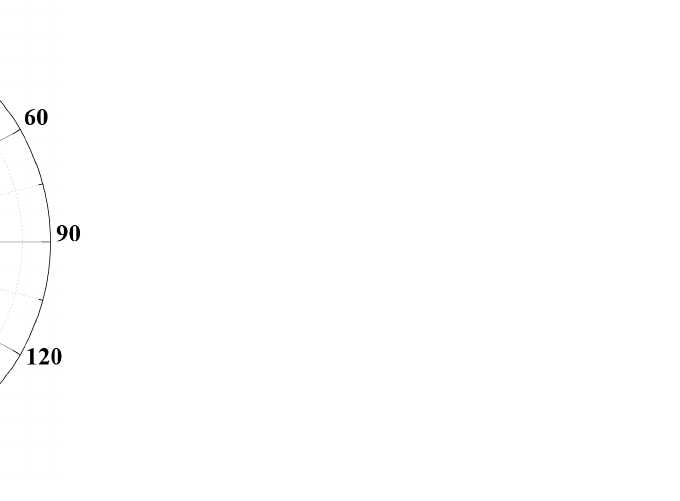
Figure 9. Angular heat flux graph for saturated steam condensation on the outer surface of a horizontal